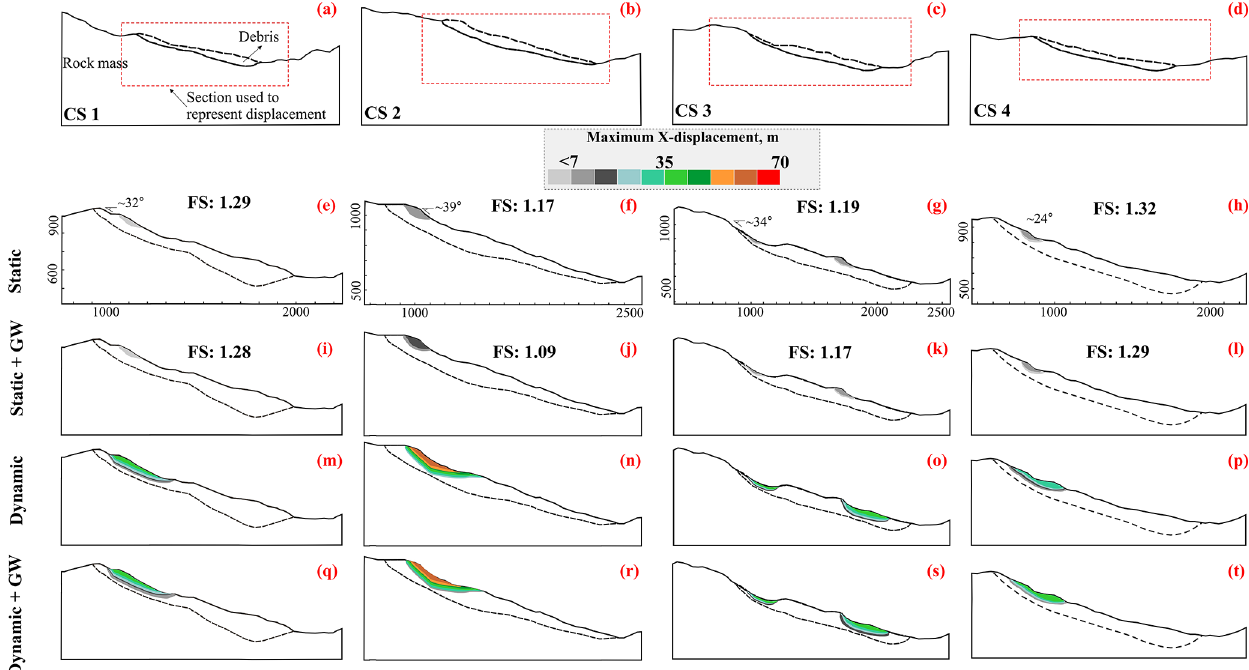
Figure 8. Factor of safety (FS) and material displacement ( x direction). Panels (a) – (d) refer to original slope sections with sub-sections (red rectangle) used to represent displacement. Panels (e) – (t) refer to displacement in static, static + GW, dynamic, and dynamic + GW conditions.